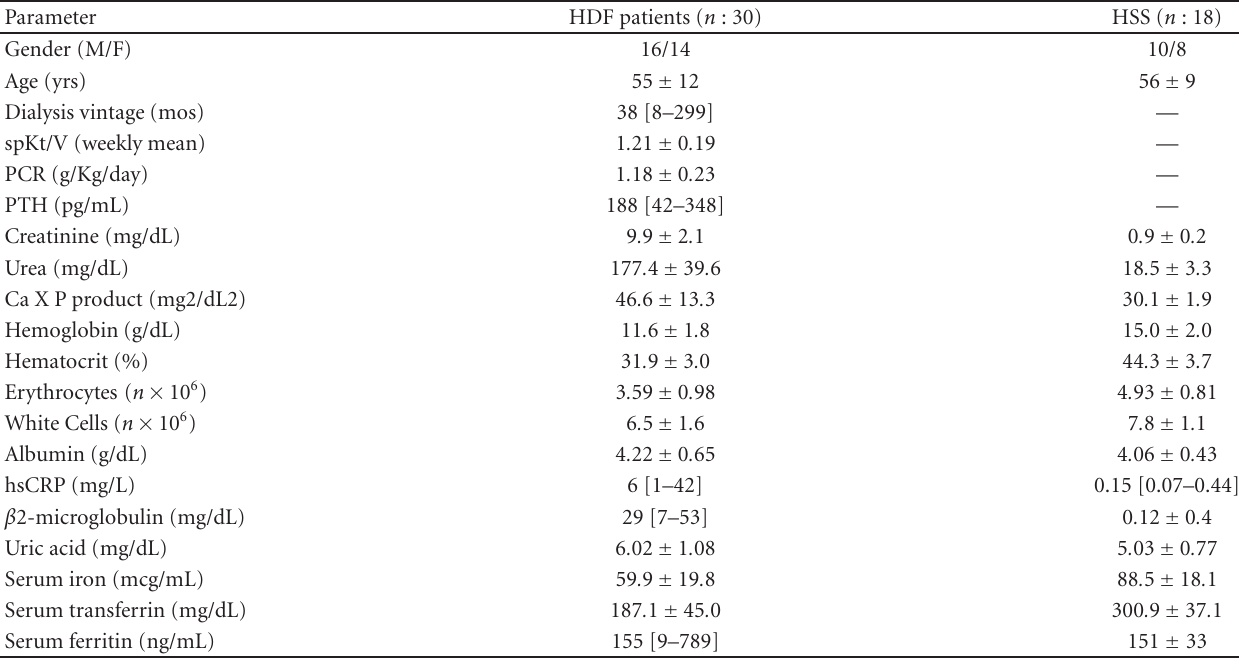
Table 1: Main characteristics of the study cohort.